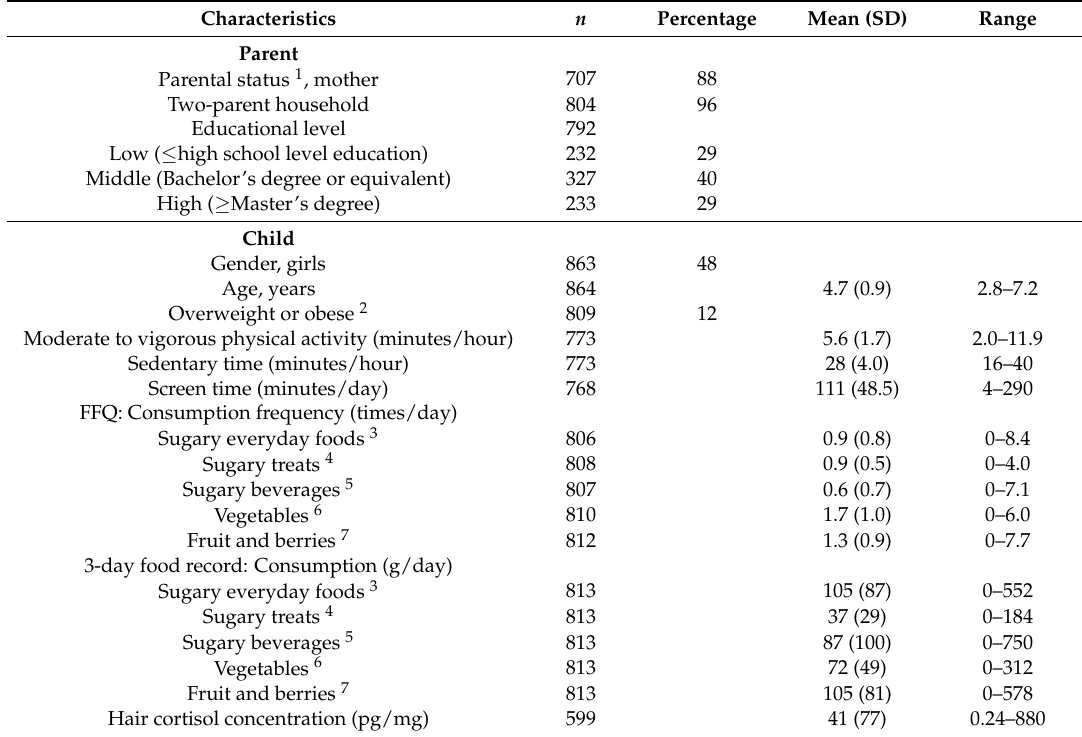
Table 1. Sample characteristics of the DAGIS study presented as percentage or mean, standard deviation (SD), and